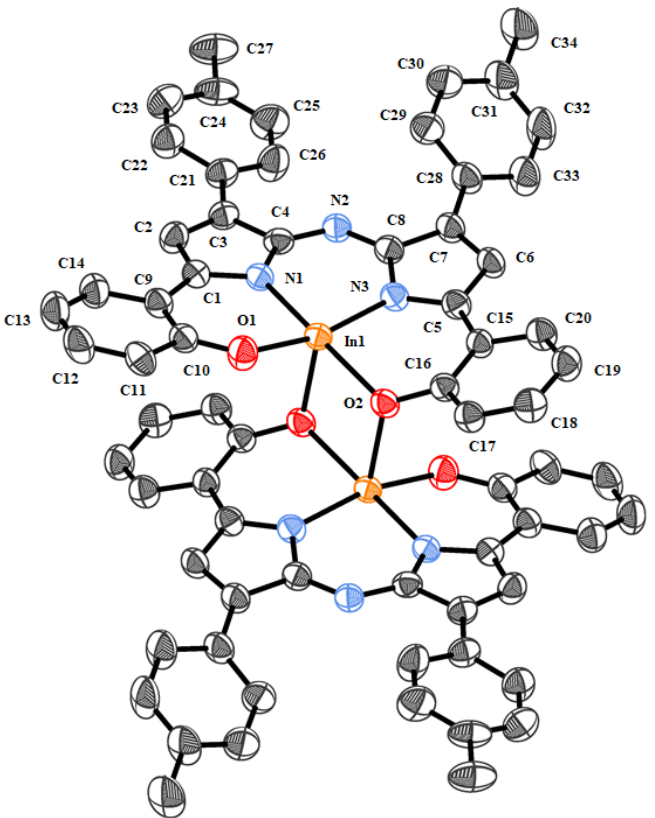
Figure 4. Molecular structure of 4a ’ . Ellipsoids are drawn at the 40% probability level. Axial THF groups and hydrogen atoms have been removed for clarity.